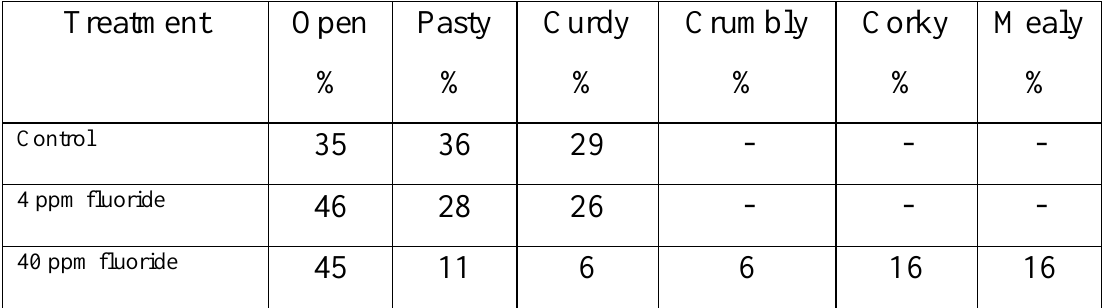
Table (4): Effect of fluoride on body / texture criticism of Cheddar cheese after 120 days.